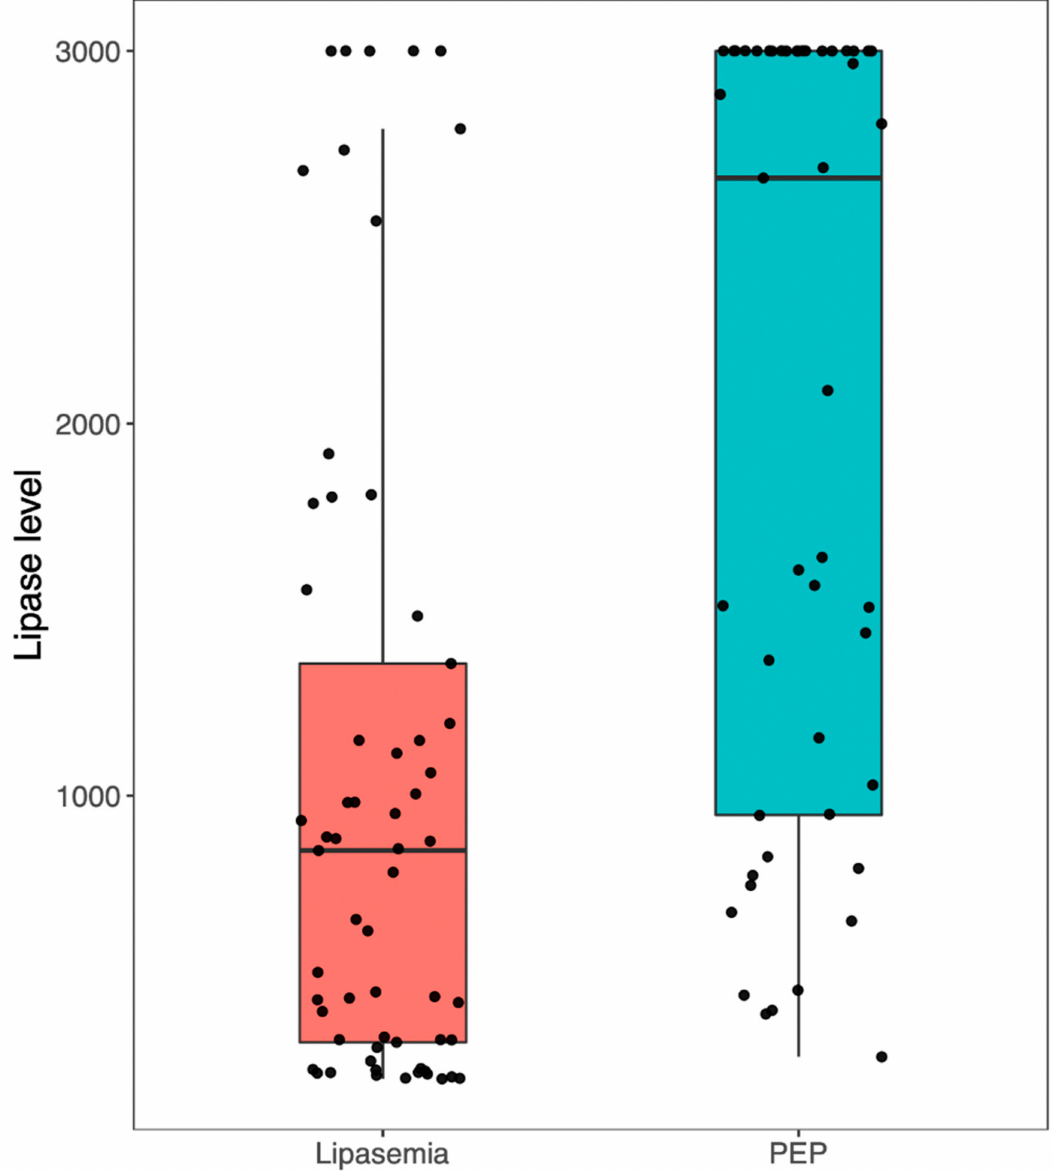
Figure 2. Distribution of lipase levels (measured on the day following ERCP) for patients with asymp- tomatic lipasemia and PEP. Highest value of lipase reported as ‘>3000 U/L’. PEP, post-endoscopic retrograde cholangiopancreatography